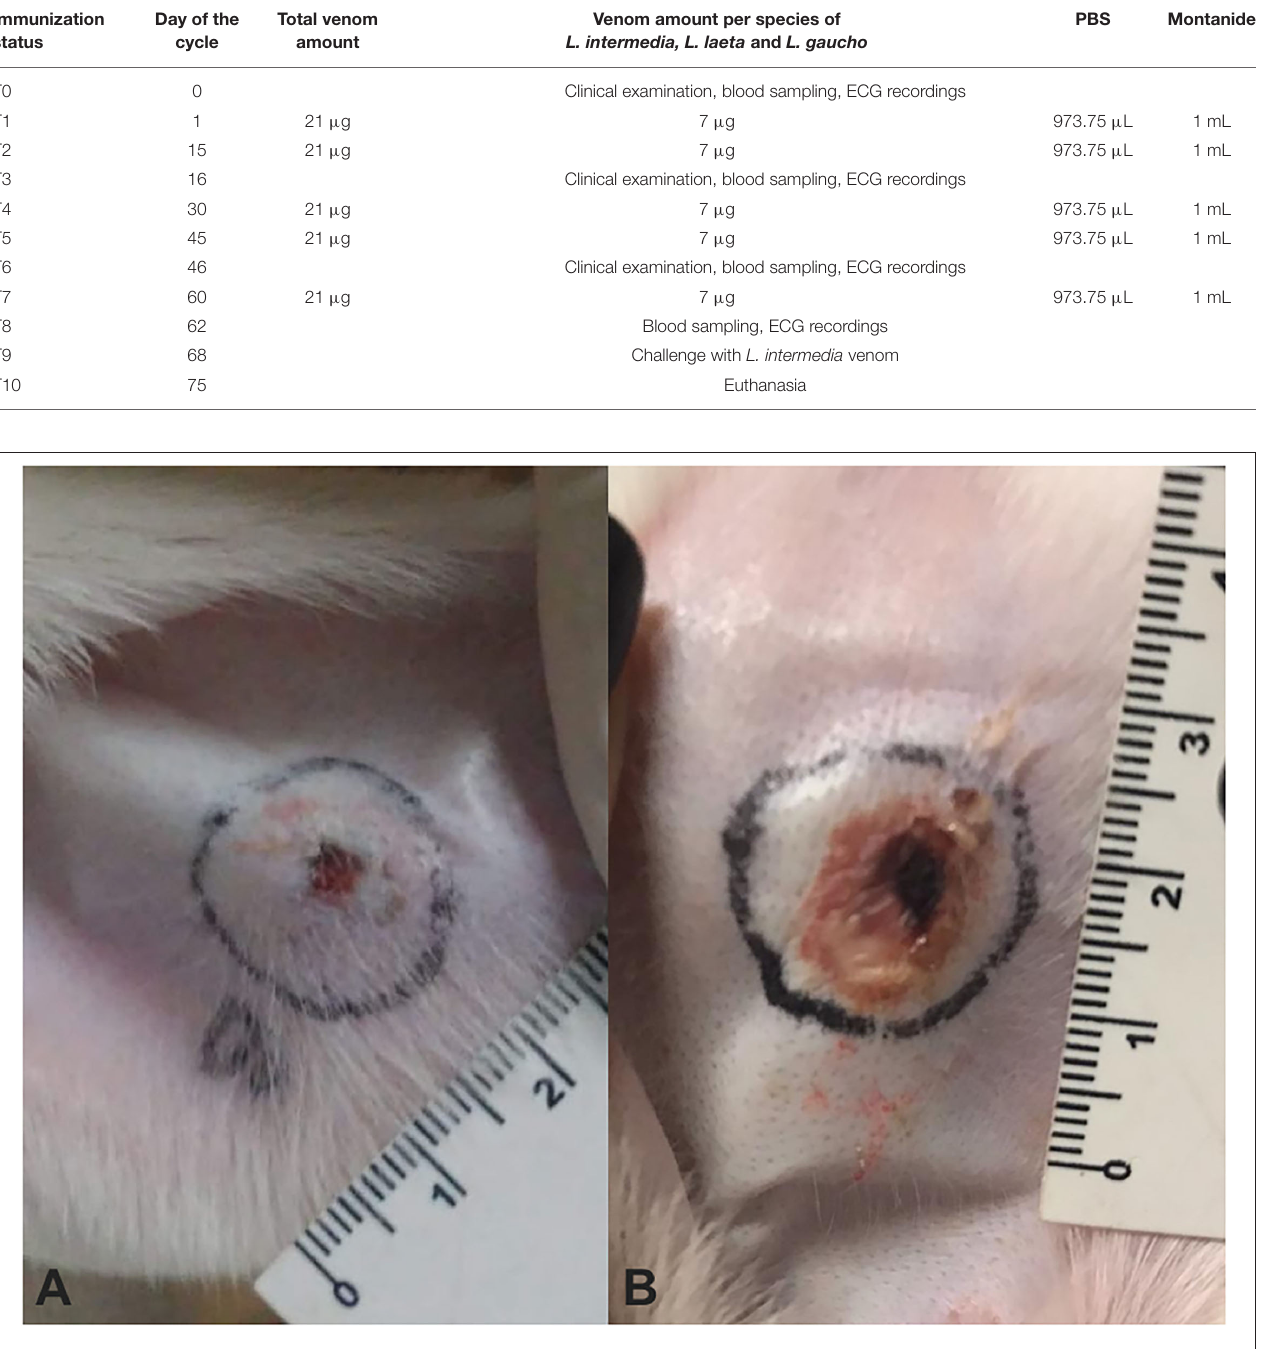
(4 µ m thickness) of paraffin-embedded fragments were dyed with hematoxylin and eosin (HE) and periodic acid Schiff (P.A.S.) for pathological examination under light